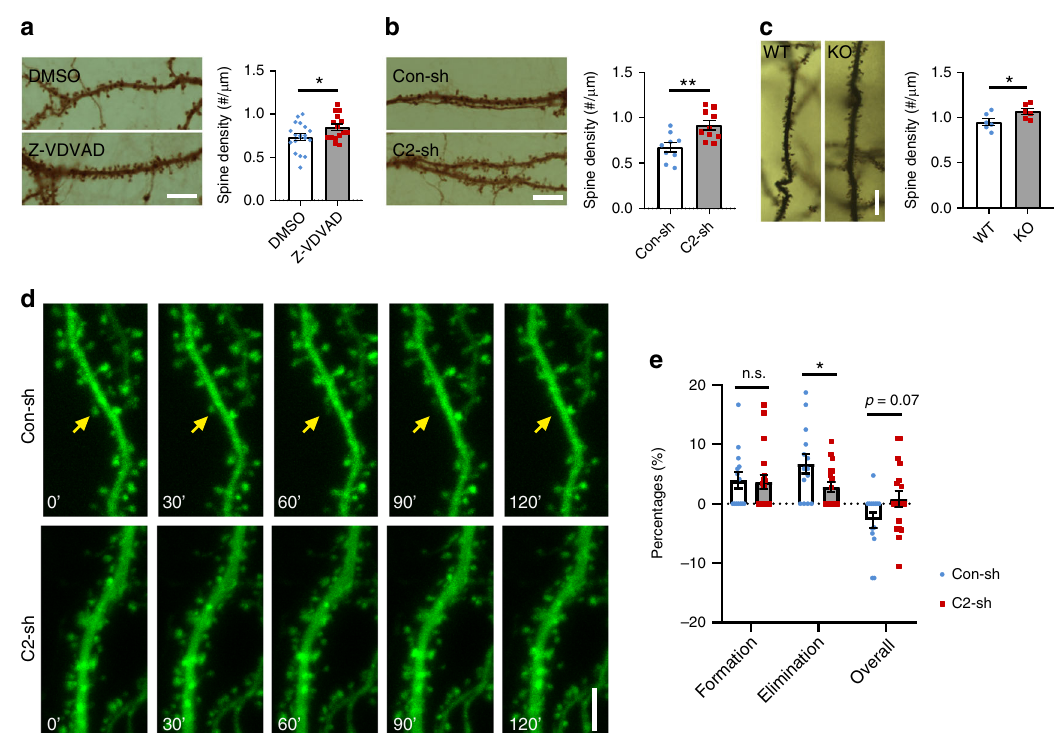
Fig. 1 Caspase-2 de fi ciency increases spine density both in vitro and in vivo. a Caspase-2 inhibitor (Z-VDVAD) signi fi cantly increased spine density in cultured rat hippocampal neurons compared with vehicle DMSO. DMSO, n = 19 neurons; Z-VDVAD, n = 15 neurons; Scale bar, 10 μ m. b Knockdown of caspase-2 with shRNA (C2-sh) increased spine density in cultured rat hippocampal neurons compared with control shRNA (Con-sh). Con-sh, n = 9 neurons; C2-sh, n = 10 neurons; Scale bar, 10 μ m. c Increased spine density in CA1 neurons of Casp2 KO mice. WT and KO, n = 6 mice; Scale bar, 10 μ m. d , e Live-cell imaging revealed that spine elimination, but not spine formation, was impaired in caspase-2 knockdown neurons. Con-sh, n = 14 neurons; C2- sh, n = 19 neurons; Scale bar, 5 μ m. Neurons were from at least three independent rat hippocampal cultures for analysis of dendritic spines. Data are expressed as mean ± SEM. Two-tailed Student ’ s t test: * p < 0.05 and ** p < 0.01. Source data are provided as a Source Data fi